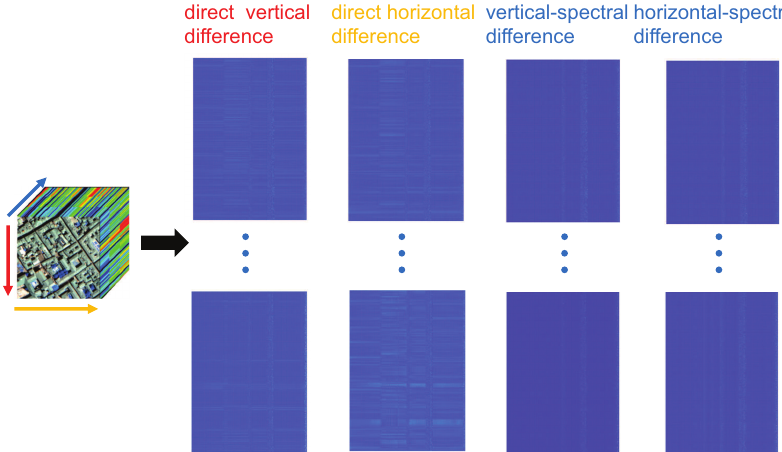
Figure 2. The group sparsity of HSSTV.